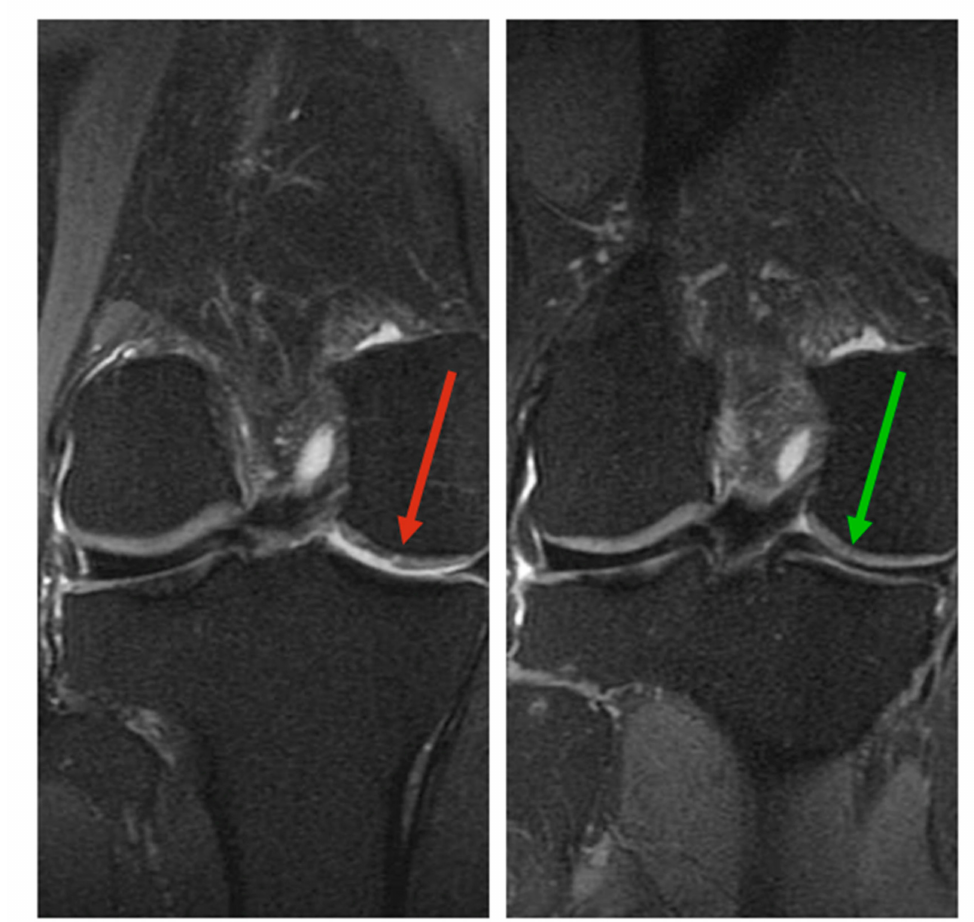
Figure 3. Magnetic resonance imaging (MRI) status of the right knee joint before treatment with the SVF ( left ), showing lesion in the cartilage (red arrow) and 16 months after treatment with SVF ( right ), showing potential cartilage regeneration and disappearance of the e ff usion (green